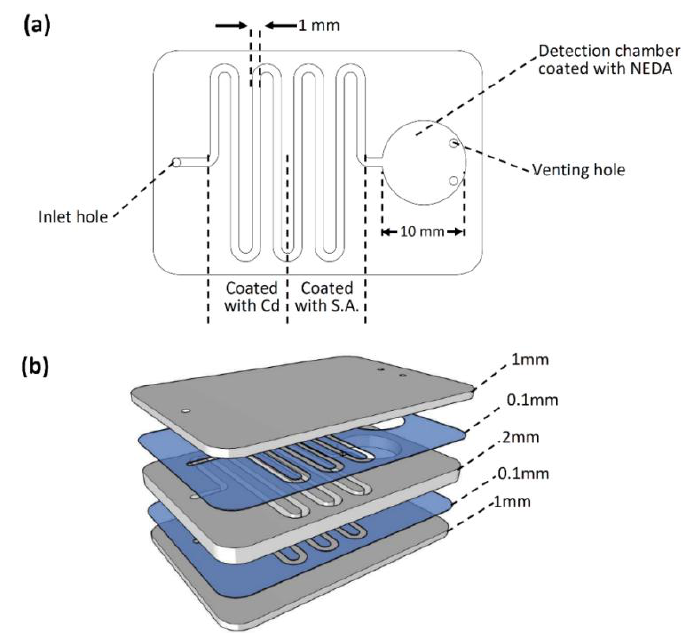
Figure 1. Microfluidic chip for nitrate detection. ( a ) Chip design where a 1 mm × 2 mm spiral channel with one inlet is connected to a final detection chamber; ( b ) microfluidic chip layers.